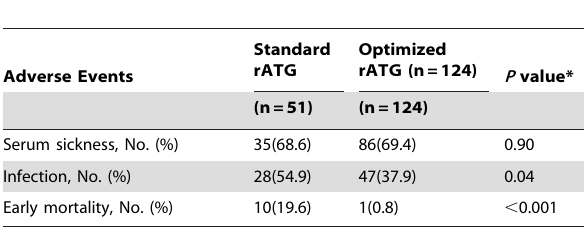
Table 3. Adverse events in 3 months after